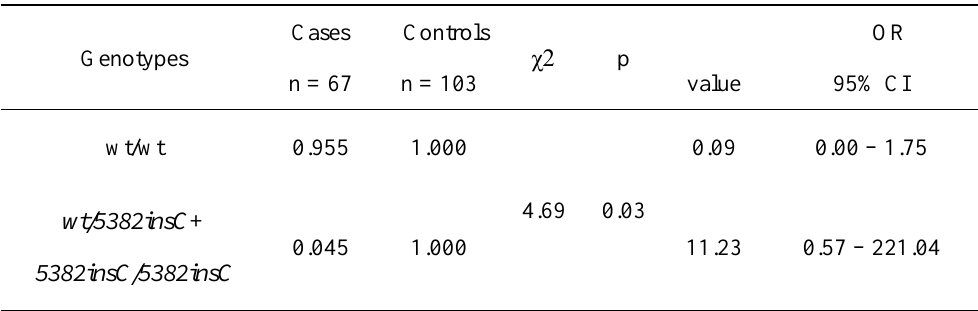
Table 3. Association between 5382insC mutation and breast cancer (χ2 test, df = 1, dominant model of